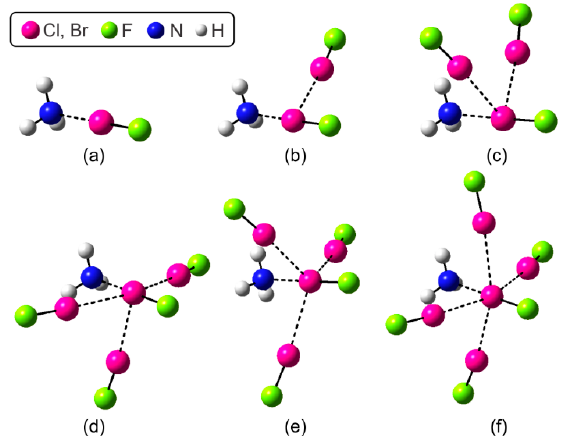
Figure 1. Molecular structures of complexes studied: ( a ) FX/NH 3 (C 3v ); ( b ) (FX) 2 /NH 3 (C s ); ( c ) (FX) 3 /NH 3 (C s ); ( d ) (FX) 4 /NH 3 (C s ); ( e ) (FX) 4 /NH 3 (C 3v ) and ( f ) (FX) 5 /NH 3 (C s ).